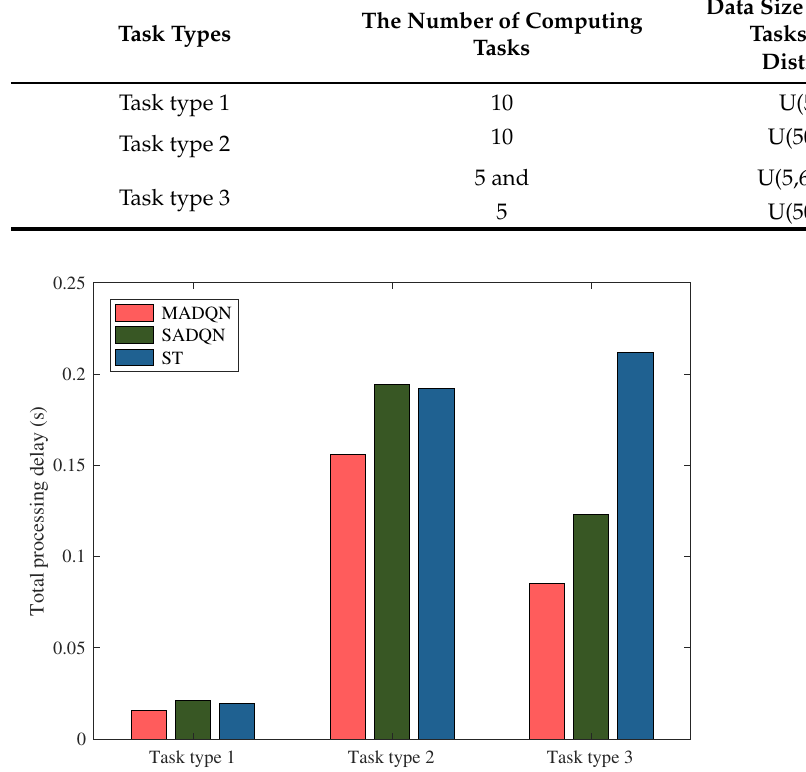
Figure 12. The effect of different data sizes of computing tasks on the total processing delay.